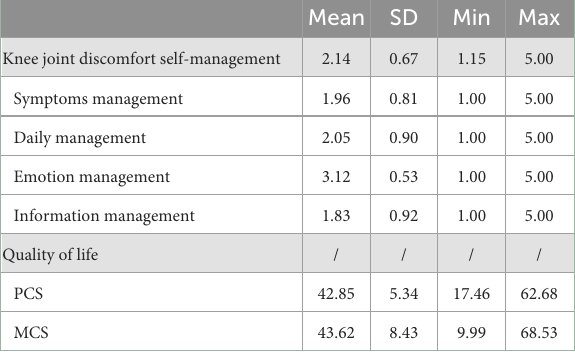
TABLE 3 Mean, standard deviation, minimum, and maximum of knee joint discomfort self-management and quality of life ( n = 9,640).